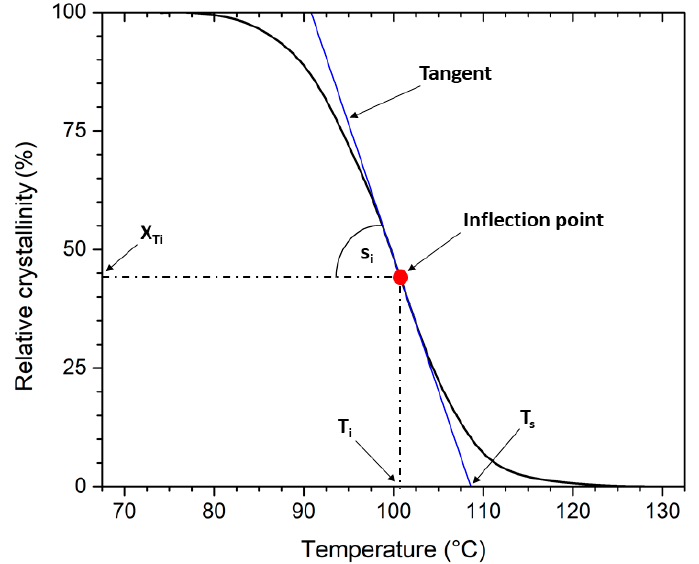
Figure 1. Schematic drawing of the non-isothermal crystallisation kinetics method by Kratochvíl and Kelnar [33]: cumulative curve.